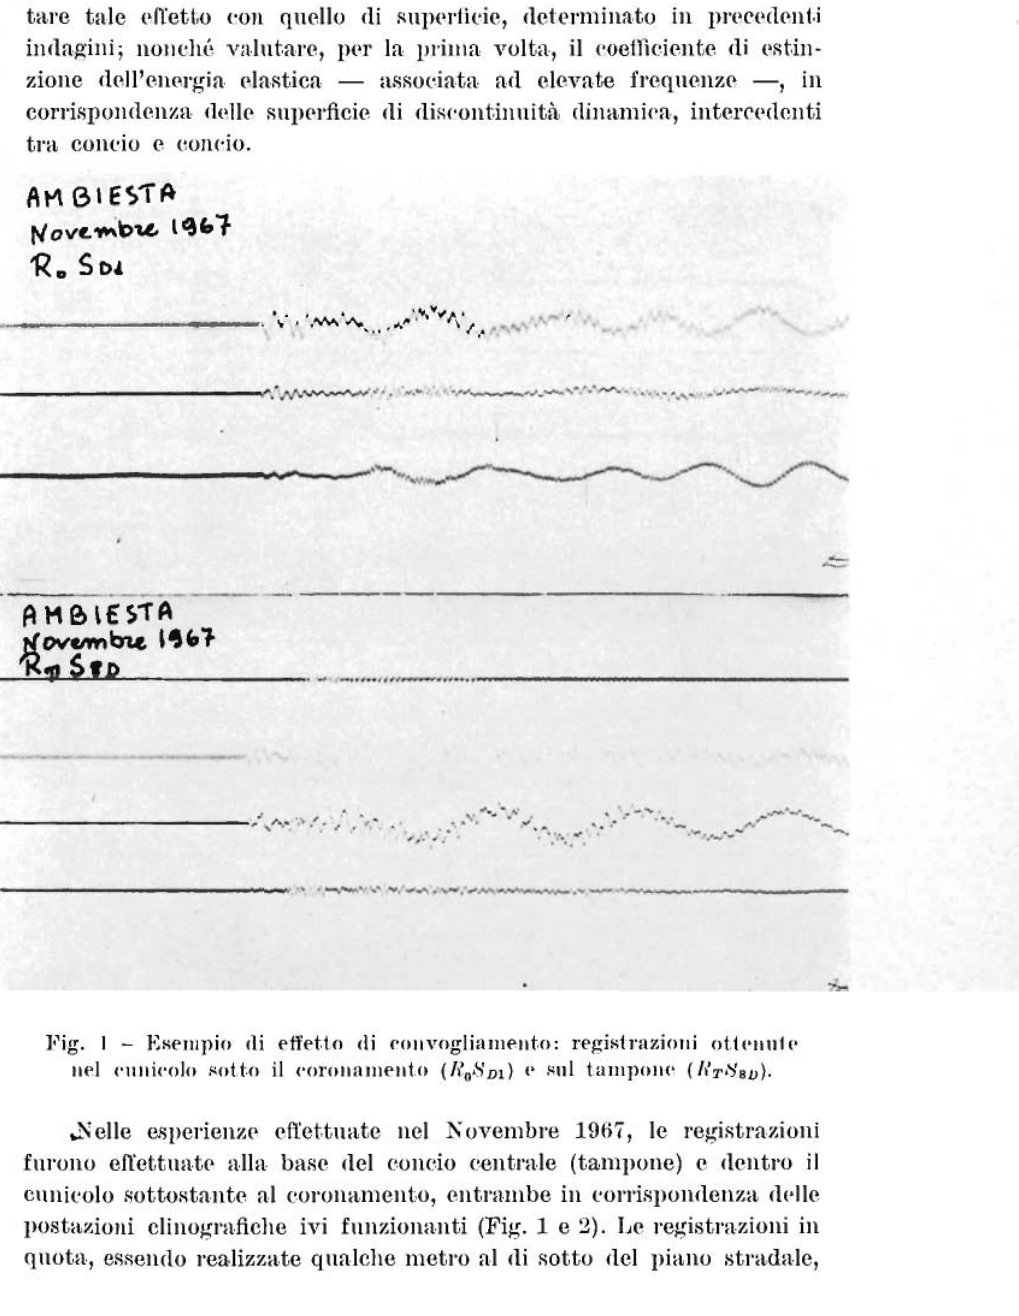
Fig. l - EHempio di elfettll Ili ('llllvllglillmelltll: l"rgistnlldoni oUplIuh' Fig. 1 - Esempio (li effetto di eonvogliamento: registrazioni ottenute Il!'1 l'nnil'olo ."ott.o il l'ommlmentll (R.'~'Dl) l' ~1I1 tUIll]lOIW (NT8~1J) . nel cunicolo sotto il coronamento ( R 0 Sm ) e sul tampone (I\'tH»d)- •. :"elle efiperienz(' pffet-.\.nate nel ),""ovembre 19fi7, le regiHtmzioni »Nelle esperienze effettuate nel Novembre 1967, le registrazioni furono efi'ett,uat(' alla baH(' del ('on('io t'entrale (tampone) (' 4}('ntro il furono effettuate alla base del concio centrale (tampone) e dentro il cunÌl'olo .~otto.~t.antp al t'oronament,o, entrambe in eoniHpomlenza d('1\e cunicolo sottostante al coronamento, entrambe in corrispondenza delle postazioni cJinografiche ivi funzionanti (Pig. l e 3). LI' regi.~t.razioni in postazioni clinografiche ivi funzionanti (Fig. .1 e 2). Le registrazioni in quota, eHfiendo realizzate qualche metro al di HOUO (lei piano quota, essendo realizzate qualche metro al di sotto del piano stradale,